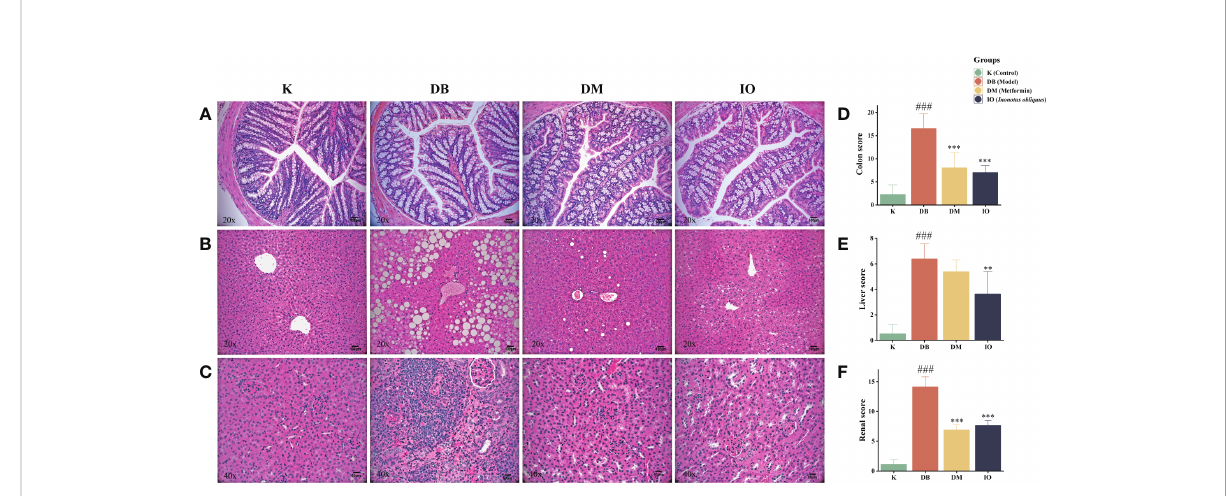
FIGURE 3 Histopathologic changes after 8 weeks of drug intervention. (A) Representative images of morphological changes in colon tissue. (B) Representative images of morphological changes in liver tissue. (C) Representative images of morphological changes in kidney tissue. (D) Histogram of colon tissue score. (E) Histogram of liver tissue score. (F) Histogram of renal tissue score. Data were expressed as the mean ± SD. ###p < 0.001 vs. K, **p < 0.01 vs. DB, ***p < 0.001 vs. DB.